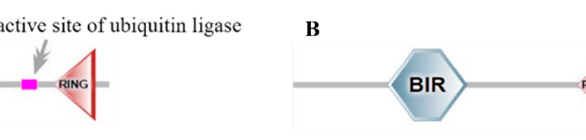
Figure 10. Analysis of BsIAPs amino acid domains and active sites. ( A ) BsIAP1. ( B ) BsIAP2. ( C ) BsIAP3.